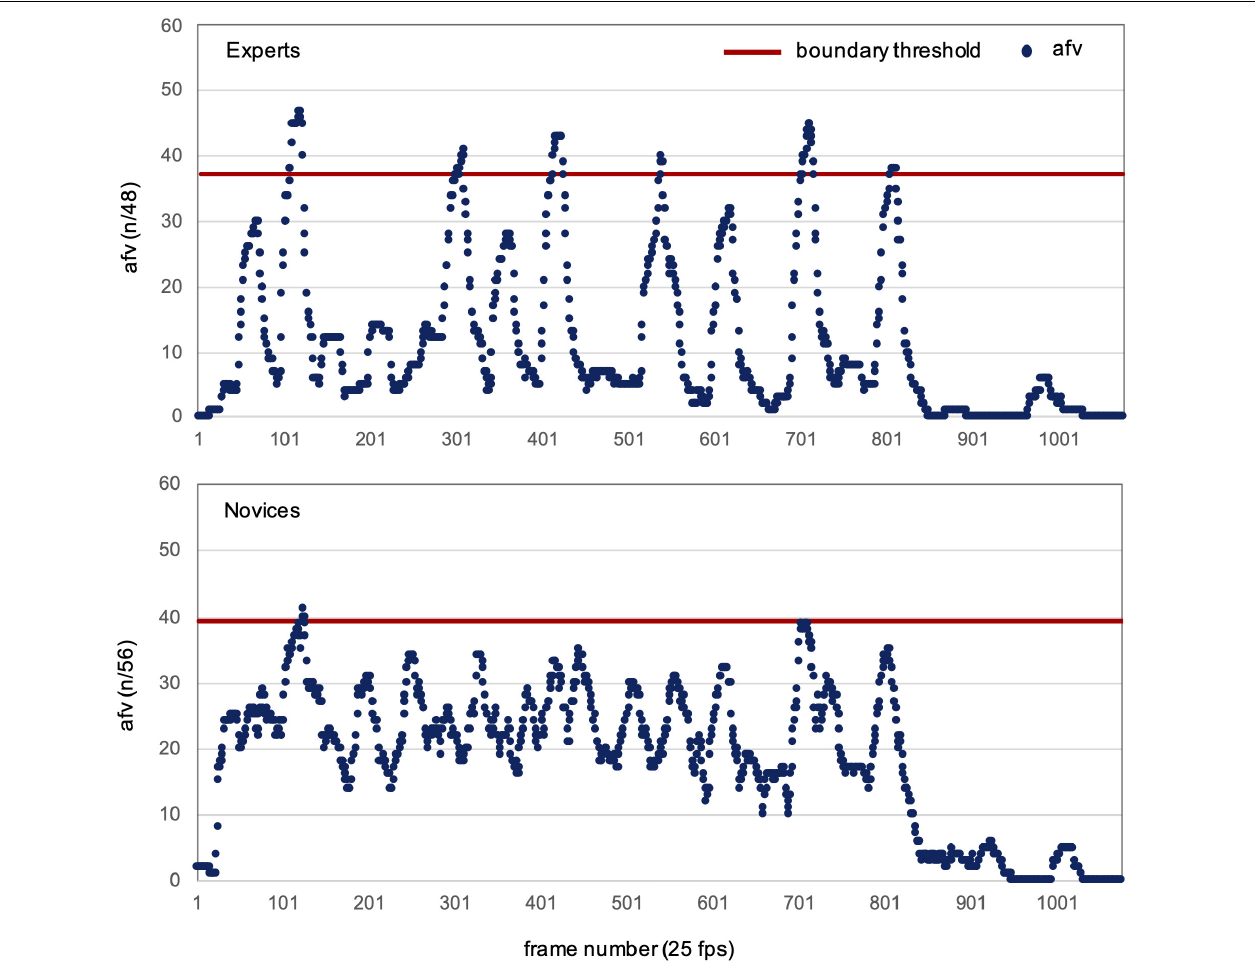
FIGURE 2 | Agreed boundaries in expert and novice groups in one exemplary video (WT Poomsae #5). The added frame values (afv, blue dots) represent the number of participants responding within each bin (i.e., within 1 s prior to each video-frame). Responses of the two blocks are summarized, thus the maximal afv achievable is double the participants in each group. Boundary threshold (red line) is 2 SD above average afv. Peaks exceeding the boundary threshold are counted (n-bound) and represent within-group agreement.